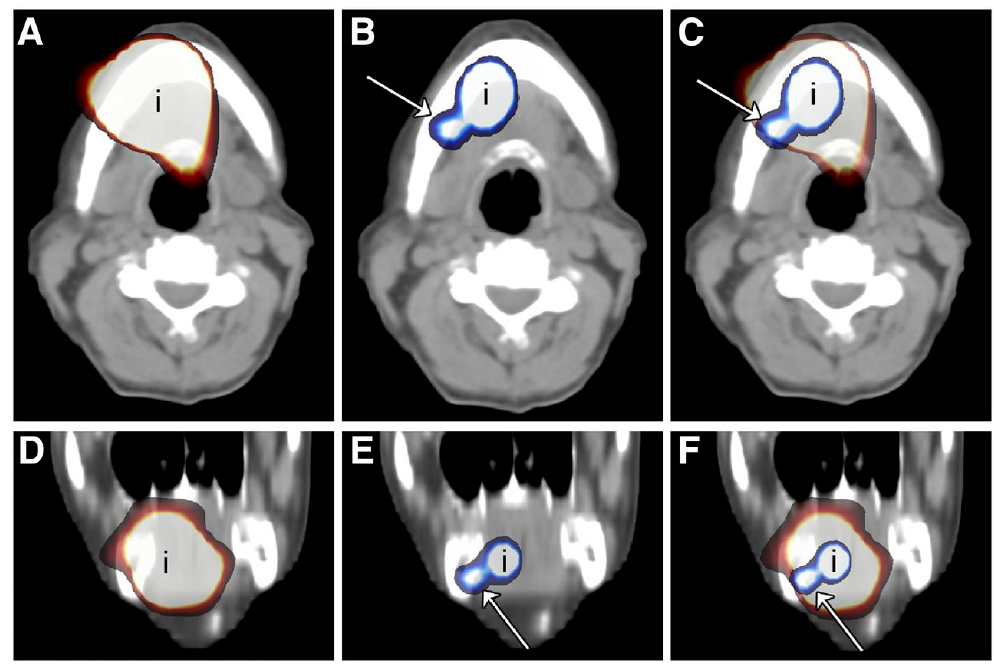
Figure 6. ( A , D ) Axial ( A ) and coronal ( D ) SPECT-CT image of injection site (i) of patient 1, i.e., floor of mouth, in which only a large hot spot from injection site could be visualized. ( B , E ) PET-CT image of injection site of same patient in which level IB lymph node (arrow) clearly could be identified. ( C , F ) Fused SPECT and PET-CT images showing that lymph node visualized on PET-CT is hidden behind large hot spot on SPECT-CT images [33]. This research was originally published in JNM [33]. Figure used with permission of original authors. ©SNMMI.